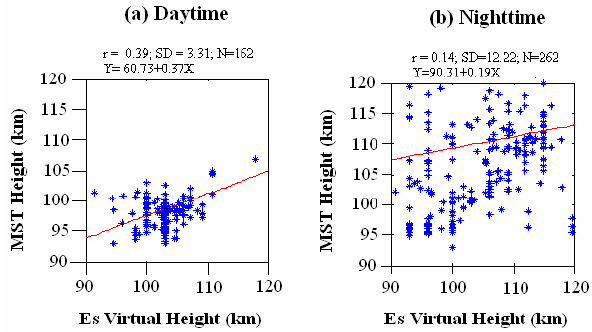
Fig. 4. Scatter plots of the virtual height of E s (h 0 E s ) and that of the most intense FAI for ( a ) daytime and ( b ) nighttime. The correlation coefficients and least-square fit lines are also